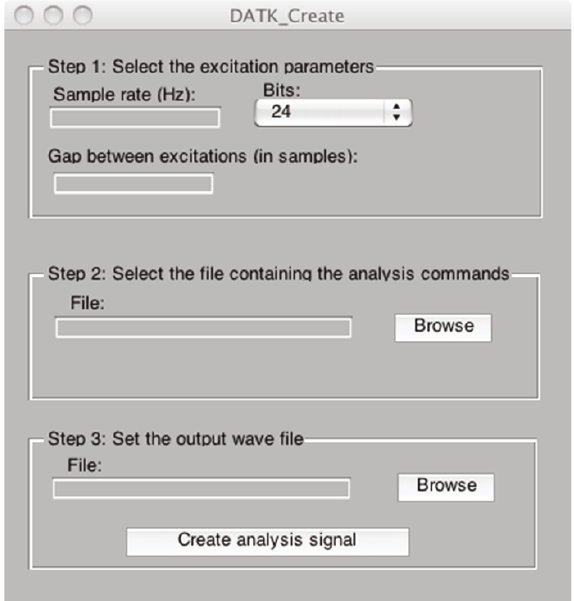
Figure 2: Dialog box for creating the analysis signal.